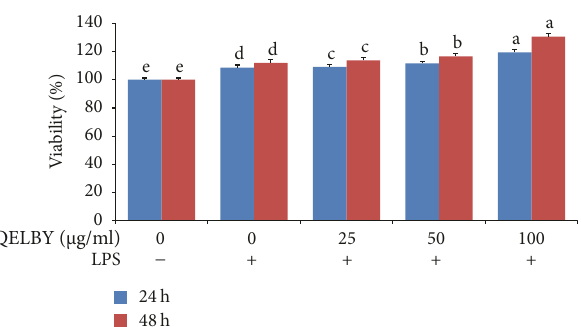
Figure 11: Evaluation of viability of mouse splenocytes incubated for 24 and 48 hours. The data shows a significant dose dependent effect on the viability of mouse splenocytes. The results are expressed as mean ± SD (𝑛 = 5) . Bars with different superscript are significantly different at 𝑝 < 0.05 .